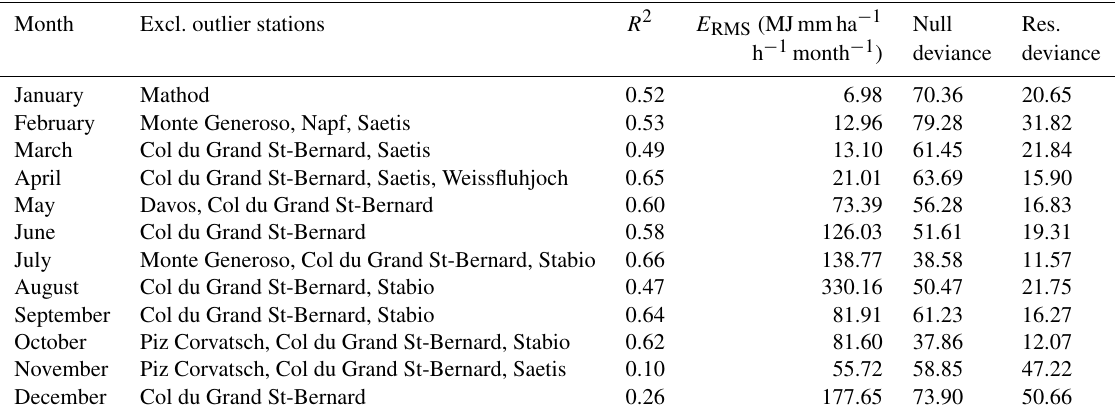
Table 3. Model efficiency by R 2 and E RMS as well as omitted outliers and influential observations per month. Month Excl. outlier